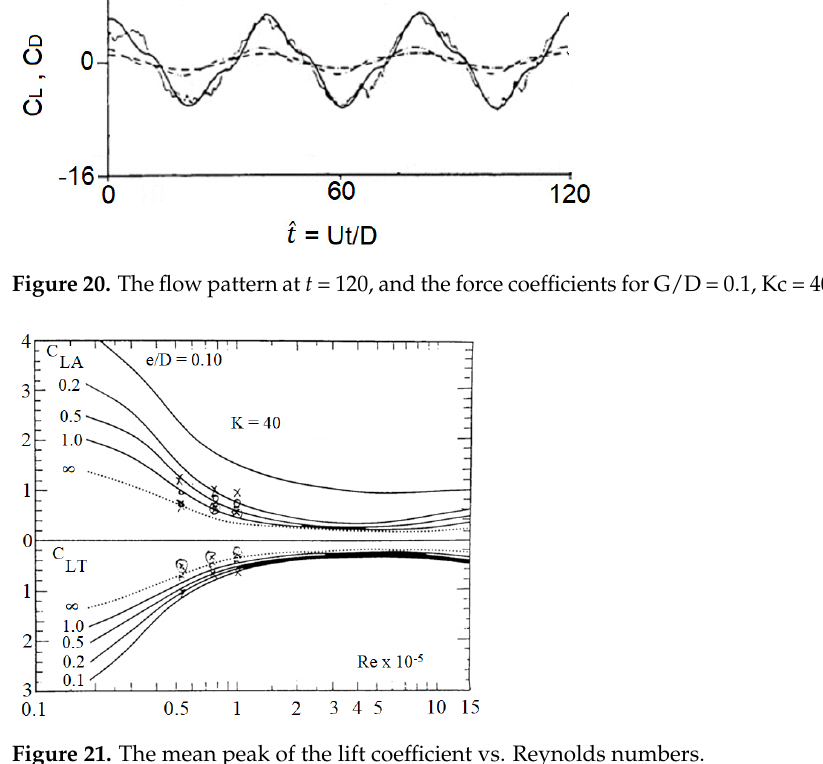
Figure 21. The mean peak of the lift coefficient vs. Reynolds numbers.